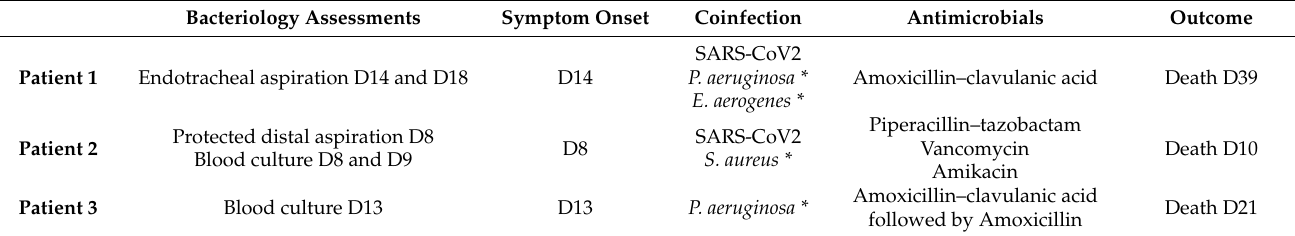
Table 2. Disease